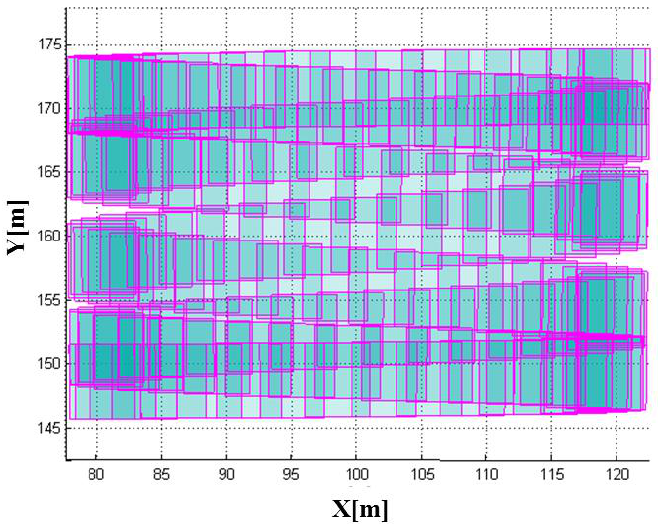
Figure 16. Coverage of FPAs by the scanning mechanism is the one bounded with red box in Figure